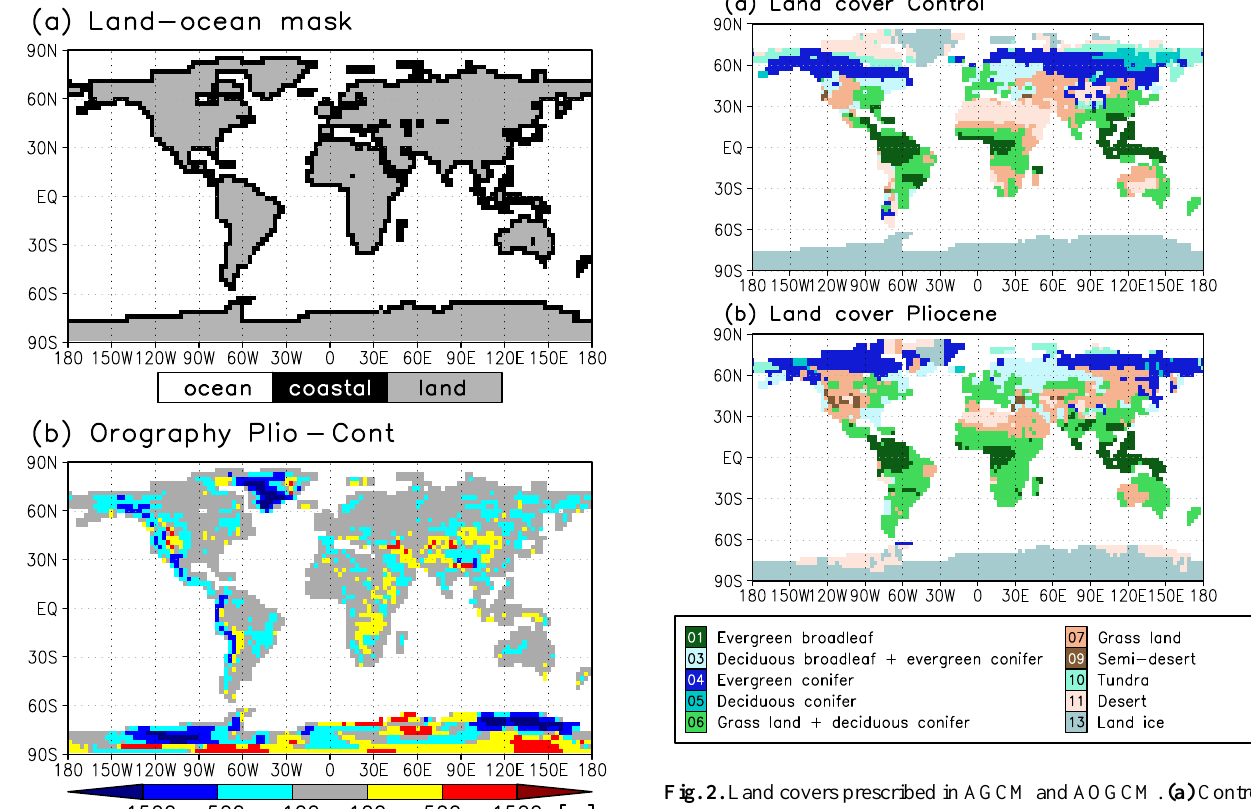
Fig. 2. Land covers prescribed in AGCM and AOGCM. (a) Control and (b) Pliocene SiB distribution. 4